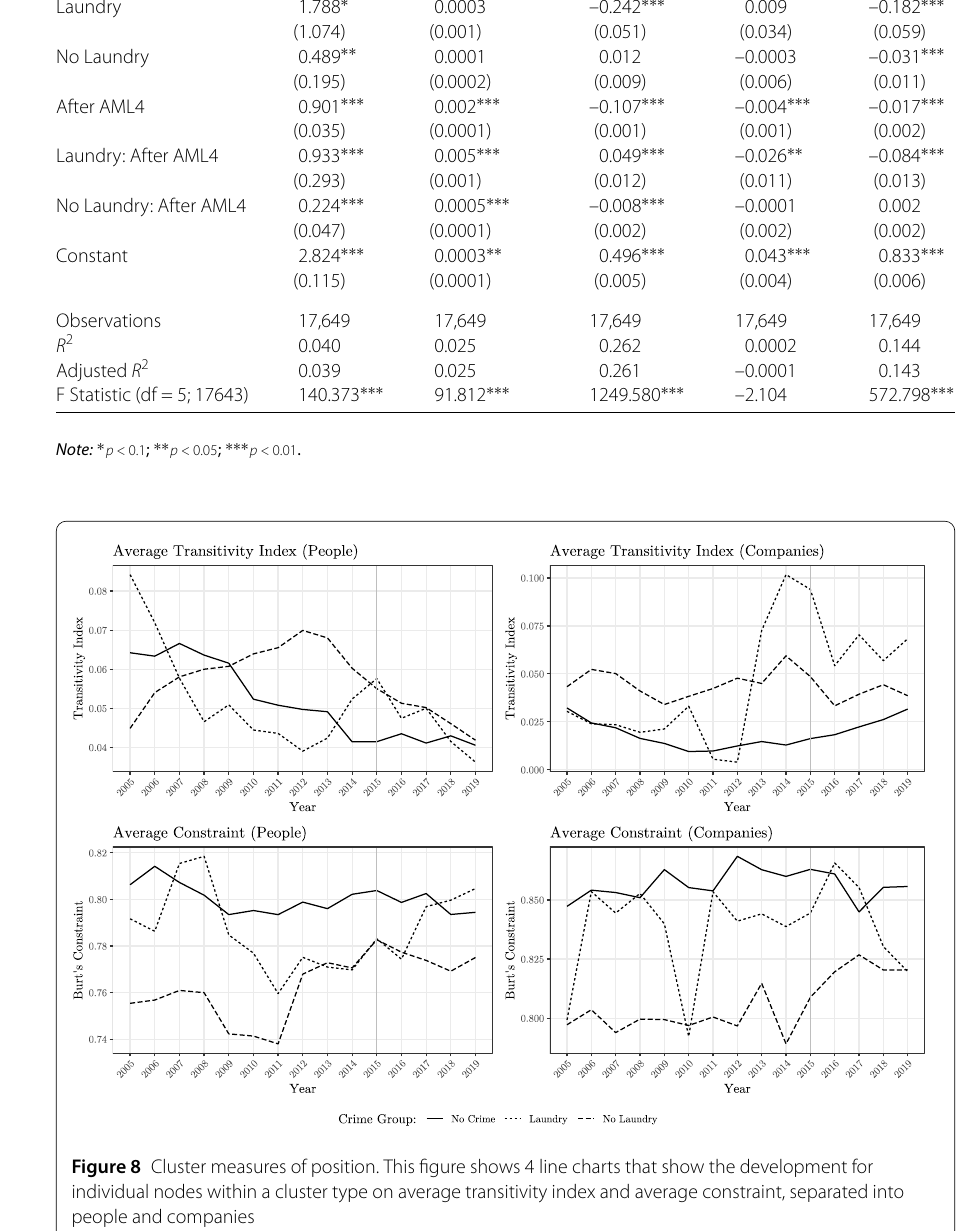
Table 8 Results of random effects regressions on individual centrality and position of people Dependent variable Centrality measures Transitivity